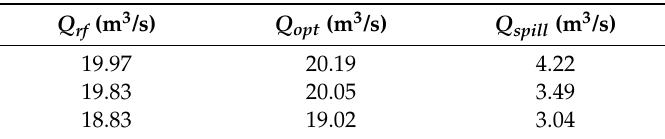
Table 3. Samples of river flows, optimum flows and spillages.